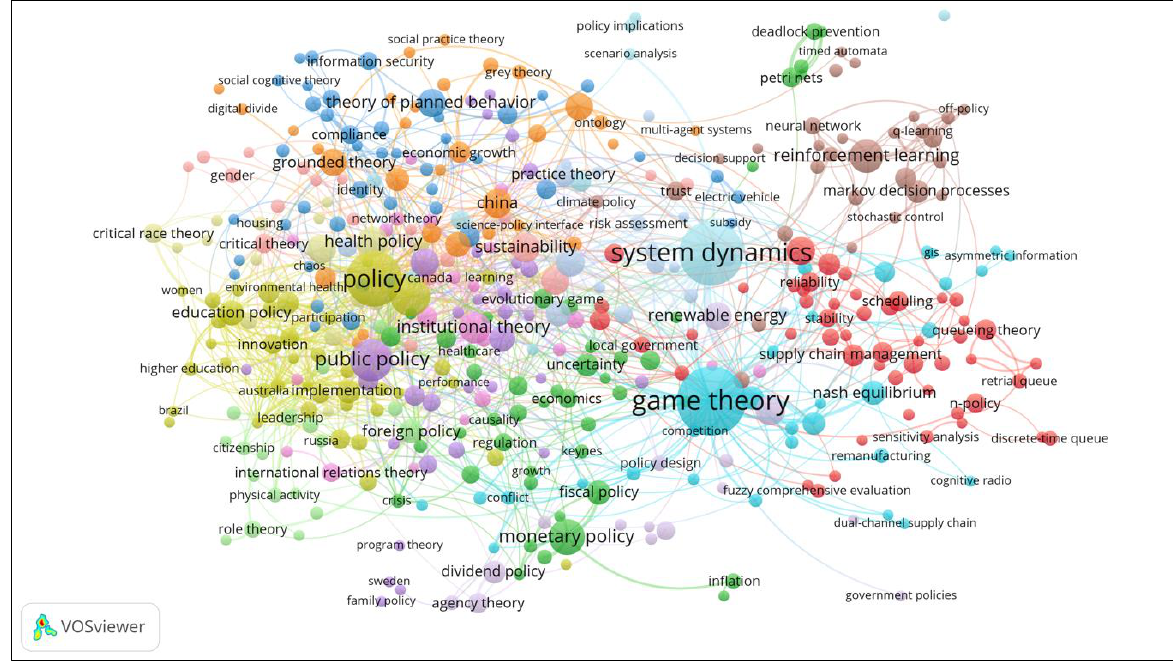
Figure 5. Co-occurrence network of the keyword in theory-related publication on a different international journal. Note: The figure illustrates the author relatedness designated and author indexed keywords (with at least ADD occurrences) based on how frequently they occur in the same publications. Nodes represent linkages and their keywords and denote co-occurrence relationships. Larger node means keywords with more occurrences. Link strength indicated the co-occur frequency. Keywords that co-occur frequently are clustered together. Nodes are colored based on the frequency with which the keyword occurs in a publication in various years. Keywords occurring with greater frequency in recent publications are colored lighter than those frequently occurring in the